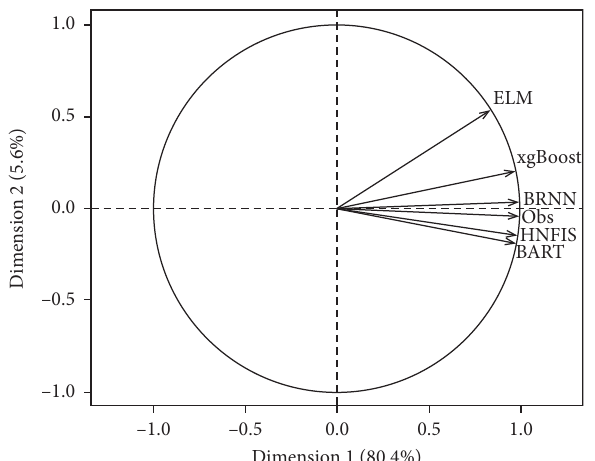
Figure 12: Assessment of similarity of model outputs with the observed rainfall-based variability plots of principal components of observed and simulated